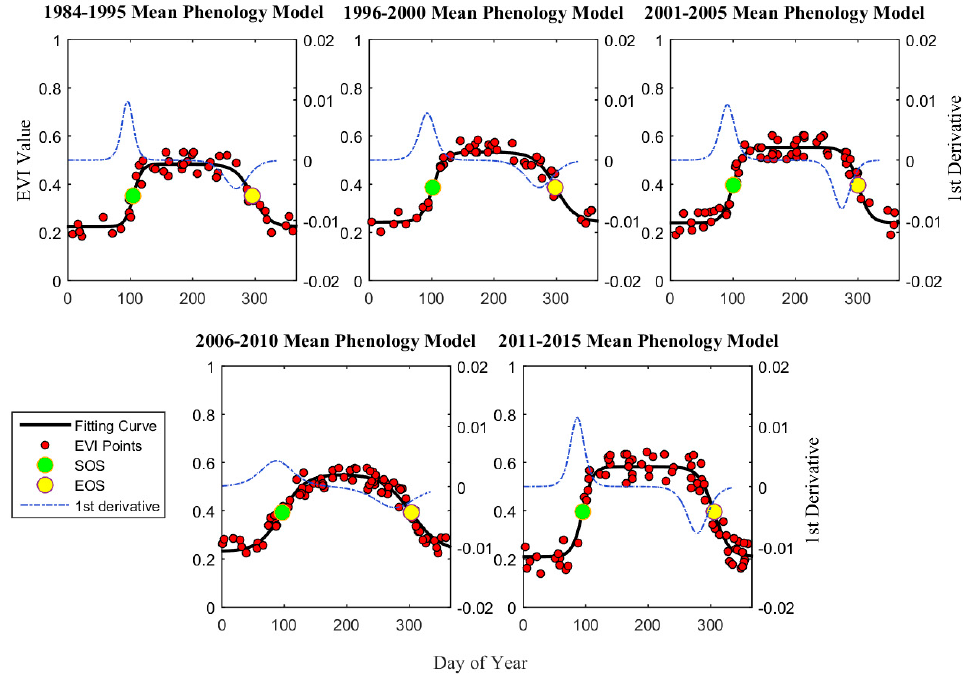
Figure 3. Mean phenology model from multi-temporal Landsat images for a pixel of typical urban vegetation located in the east-west transect for the five periods: 1984–1995, 1996–2000, 2001–2005, 2006–2010, and 2011–2015. Each red point represents one Landsat image at the corresponding DOY. Green points indicate the spring onset (SOS) and the yellow points mark the fall senescence (EOS). The black lines show the fitted different logistic curves. The dashed lines are the first derivative of the fitted curves.